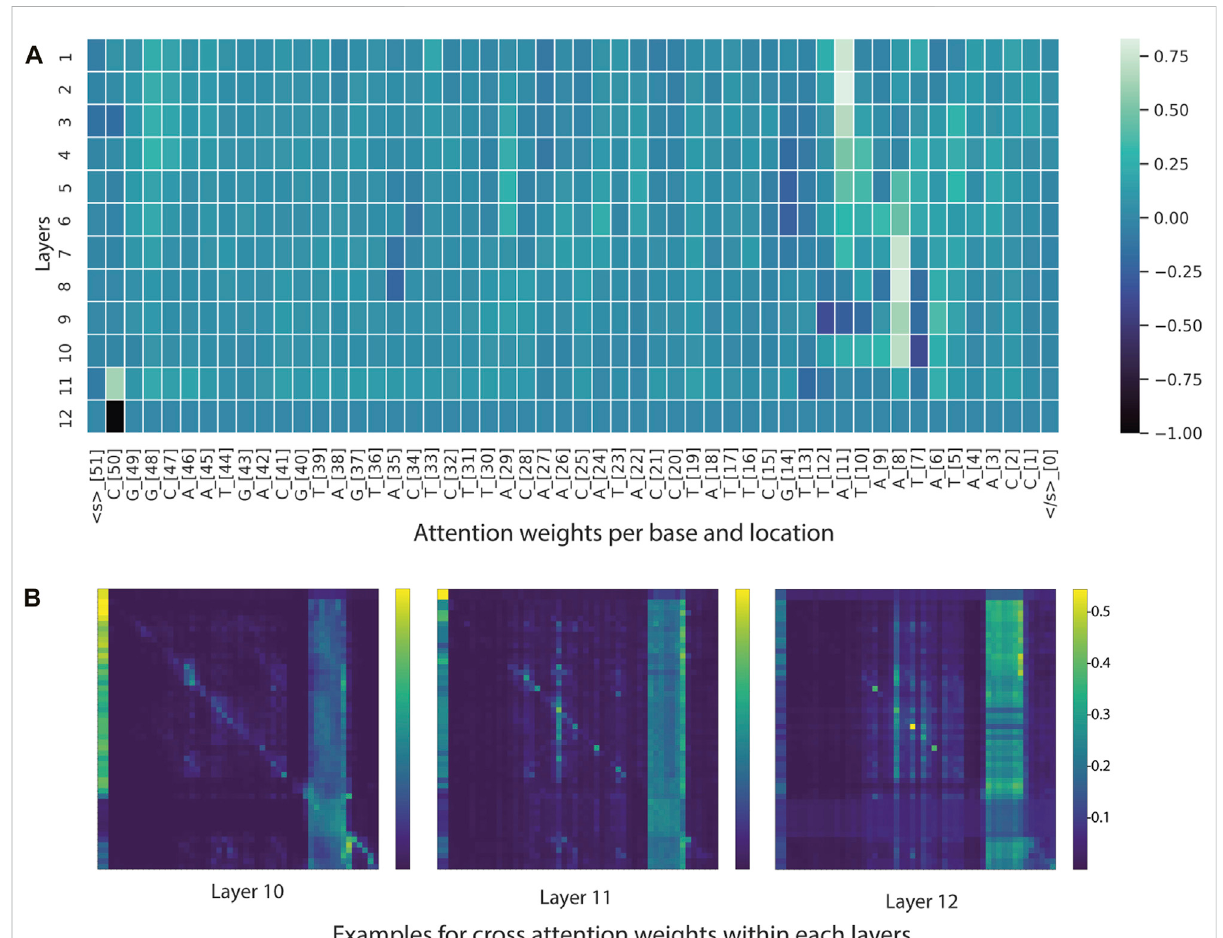
FIGURE 6 Visualization tools for model interpretability. (A) Heatmap based on attention scores of nucleotides (tokens) across 12 layers. (B) Heatmap illustrating cross-attention scores of nucleotides (tokens) in the last three layers. In the example heatmap, the self-attention modules focused on -10 element and some positions in the -35